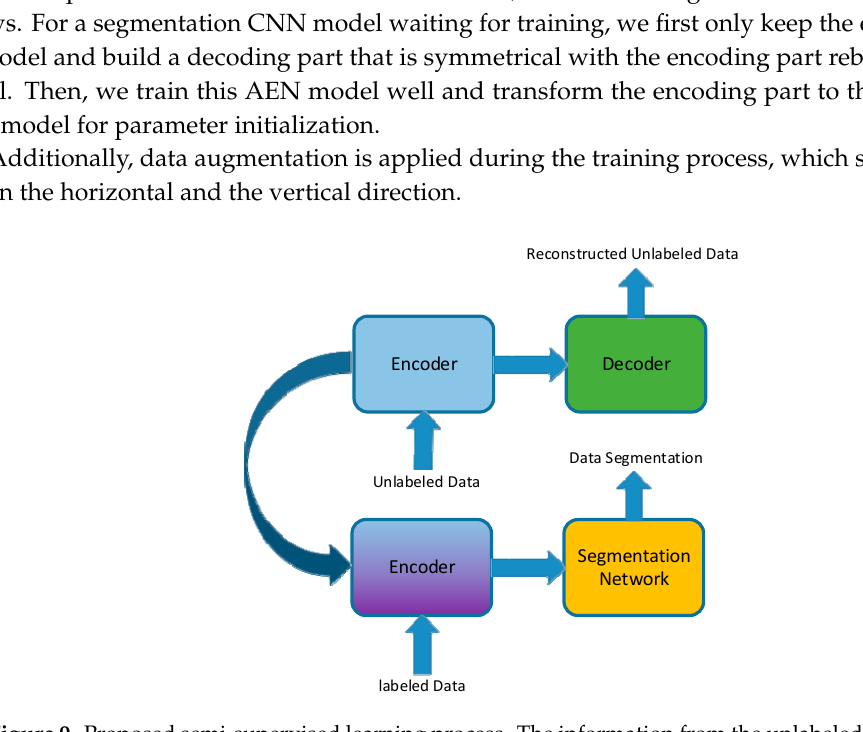
Figure 8. Construction of the proposed MAEN. The middle layer output is extracted as a semantic feature.